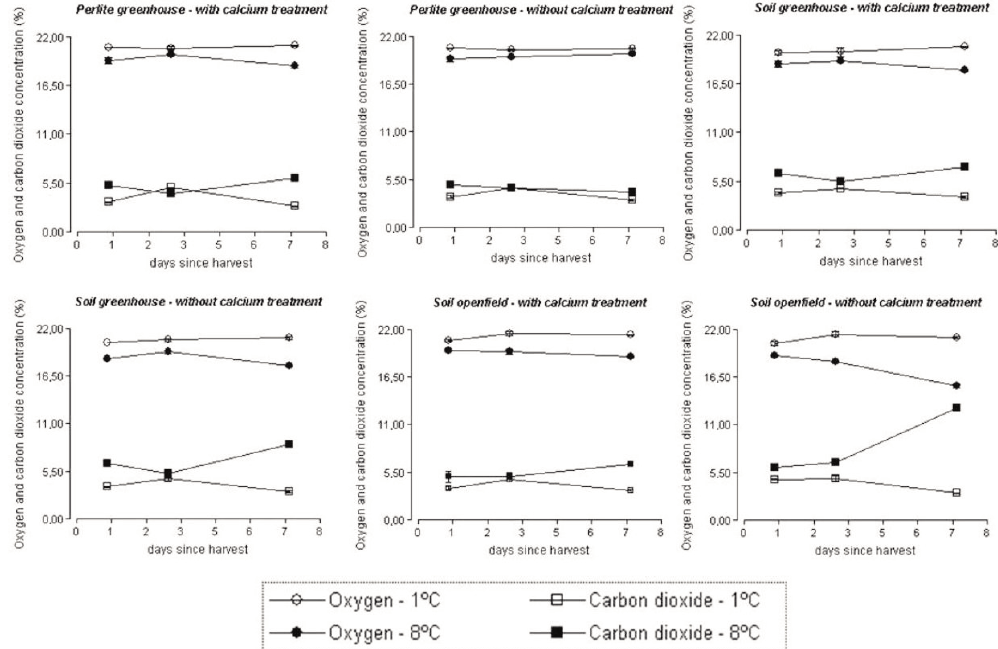
Fig. 1 - Oxygen and carbon dioxide concentration (%) in containers at 1, 3 and 7 days of postharvest of strawberries grown in different growing systems, calcium lactate treatment and two storage